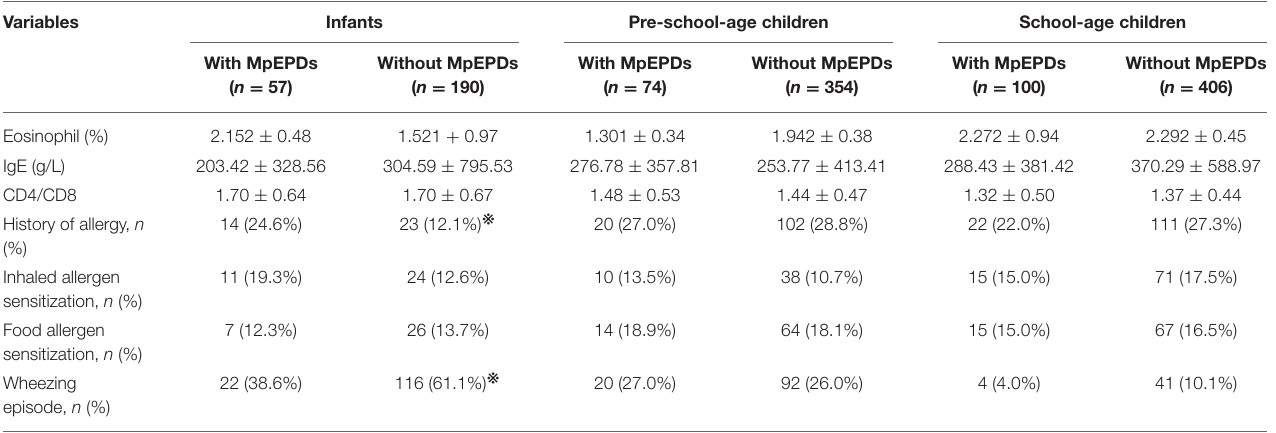
TABLE 3 | Comparison of clinical characteristic and laboratory findings in patients with and without